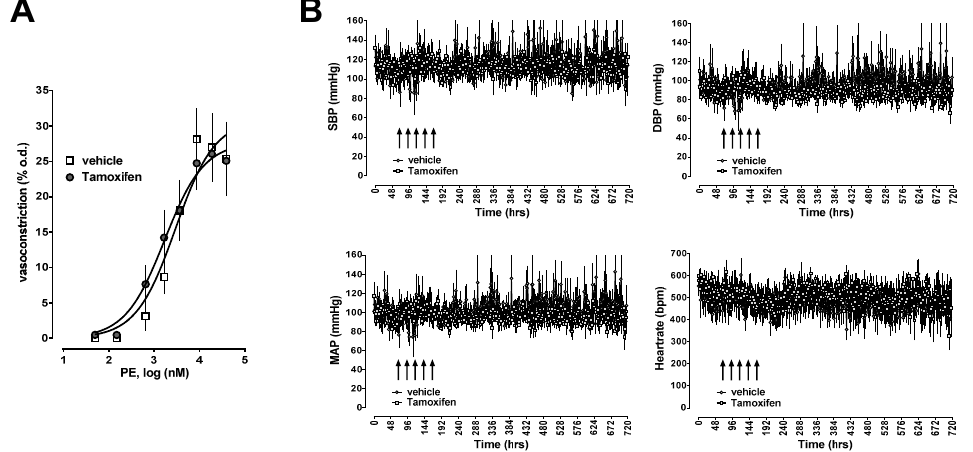
Figure 5. ( A ) Vasoconstriction was measured as change of the outer diameter (o.d.) in pressure myography experiments. Open squares: Mesenteric arteries from transgenic animals after vehicle injection, n = 12; Grey circles: Mesenteric arteries from transgenic animals after tamoxifen injection, n = 12; ( B ) Systolic (SBP), diastolic (DBP) and mean arterial blood pressures (MAP) in mmHg and heart rate (bpm, beats per minute) in transgenic animals after vehicle (open circles, n = 5) or tamoxifen (grey squares, n = 4) injection. Arrows indicate time points of tamoxifen/vehicle administration.